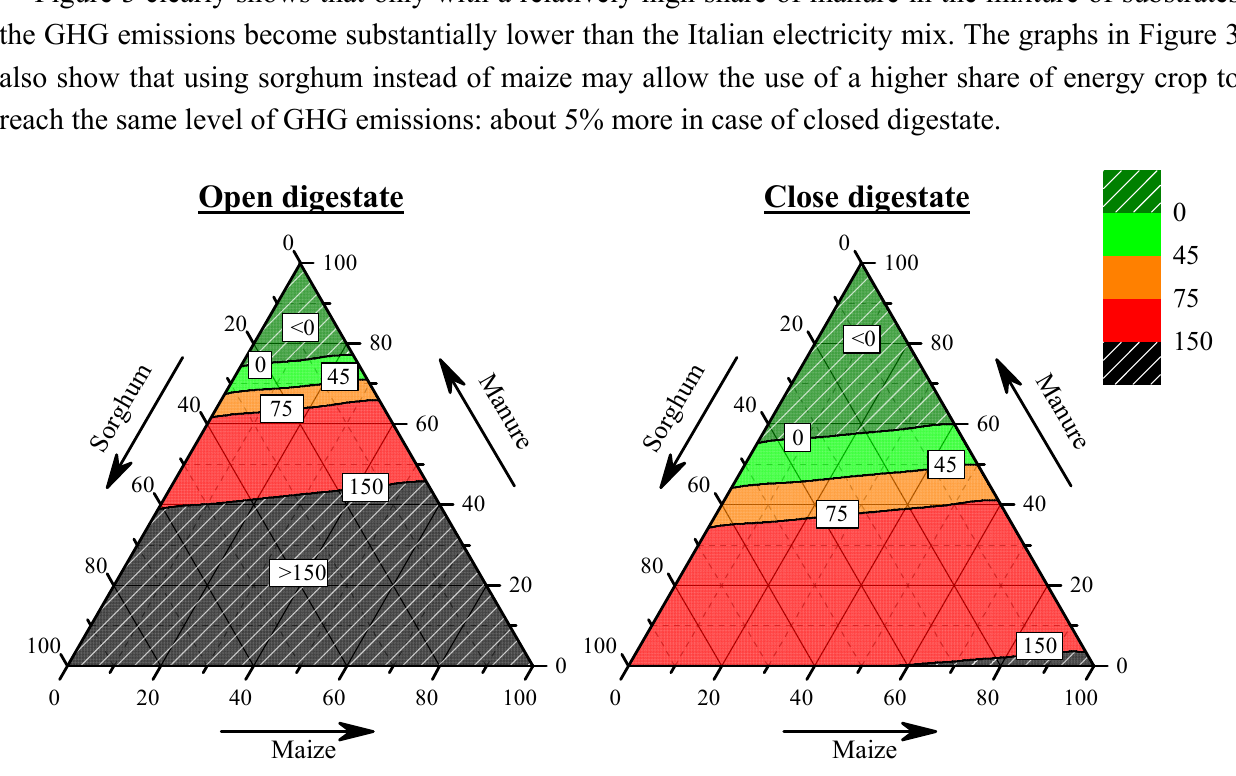
Figure 3. Representation of the GHG emissions resulting from a combination of any mixture of substrates. The shares are reported in wet mass at the input of the digester. To facilitate the interpretation relevant thresholds are highlighted. The green striped area includes systems with negative emissions. The green area represents GHG emissions between 0 and 45 gCO 2eq ·MJ − 1 el , (GHG emissions lower than 30% of the Italian electricity mix). The orange area represents emissions between 45 and 75 gCO 2eq ·MJ − 1 el , (50% of the Italian electricity mix,). The red area represents emissions between 75 and 150 gCO 2eq ·MJ − 1 el , (the GHG emissions of the Italian electricity mix). In the black striped area are included the combinations with emissions higher than the Italian electricity